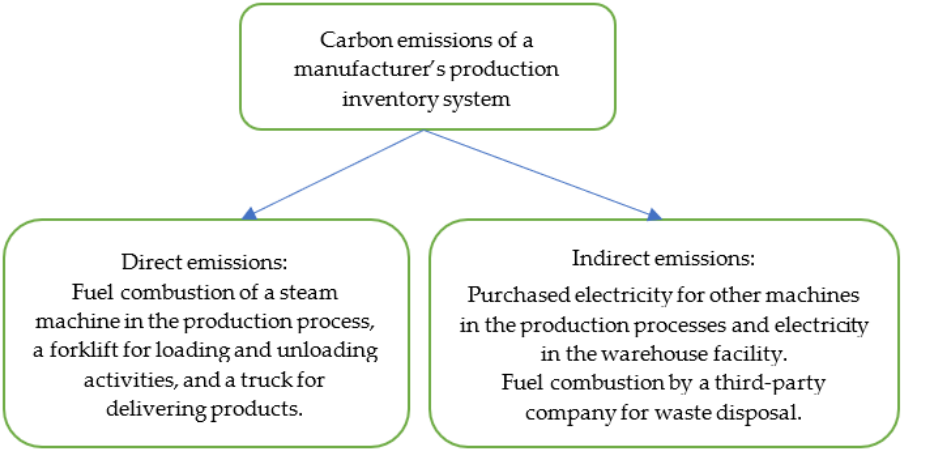
Figure 1. Classification of carbon emissions in this study.